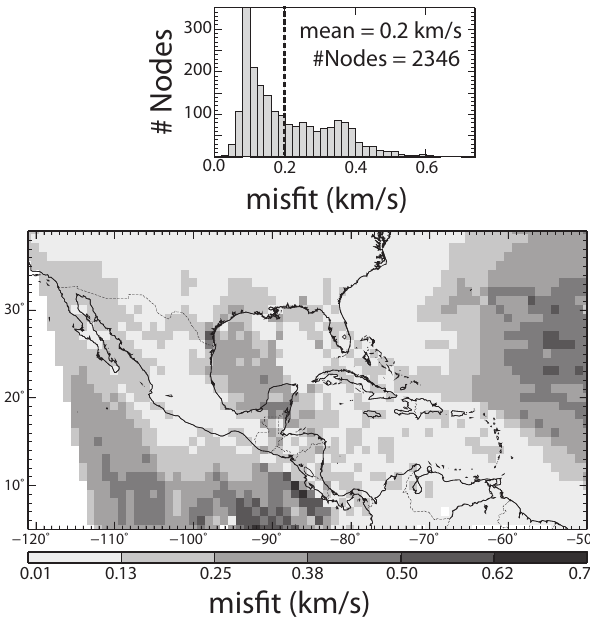
Figure 7. (a) Histogram and (b) map of the misfit of inverted dis- persion curves at each